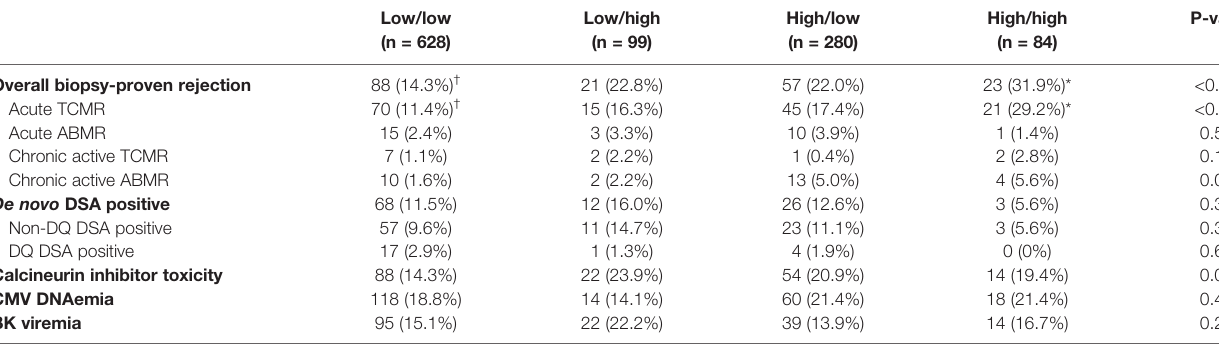
TABLE 3 | Incidences of BPAR and other complications according to TAC-C0-TWCV during post-transplant 0 – 1 st and 1 st – 2 nd